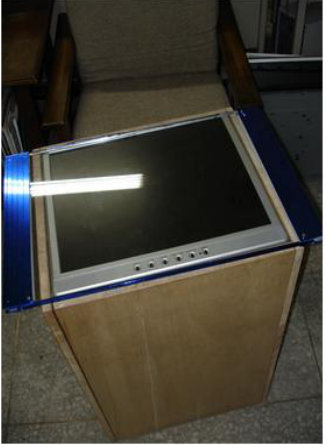
Figure 10. The prototype system of the proposed multi-touch sensing and display